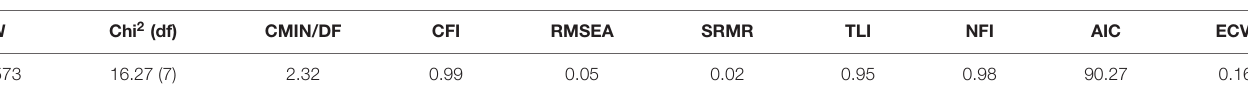
TABLE 3 | Summary of fit